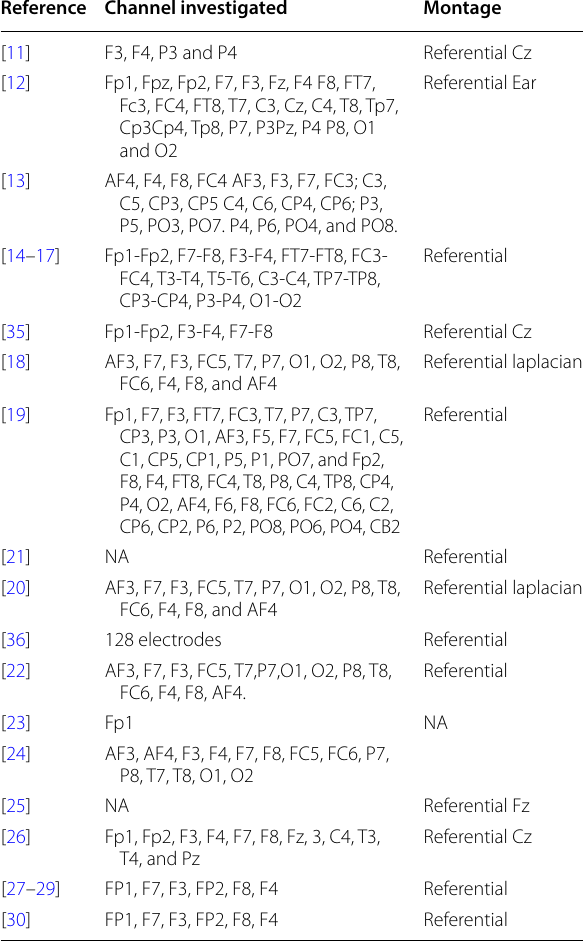
Table 6 Analysis on the basis preprocessing for artefact removal and feature extraction